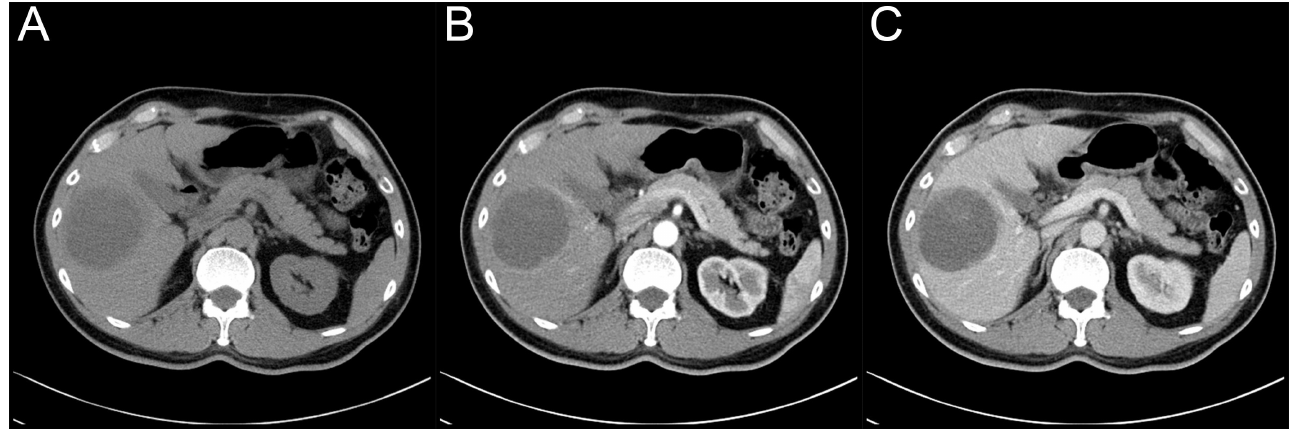
FIGURE 1. Preoperative CT evaluation (A) plain CT scanning (B) artery phase of enhanced CT scanning (C) portal vein phase of enhanced CT scanning.